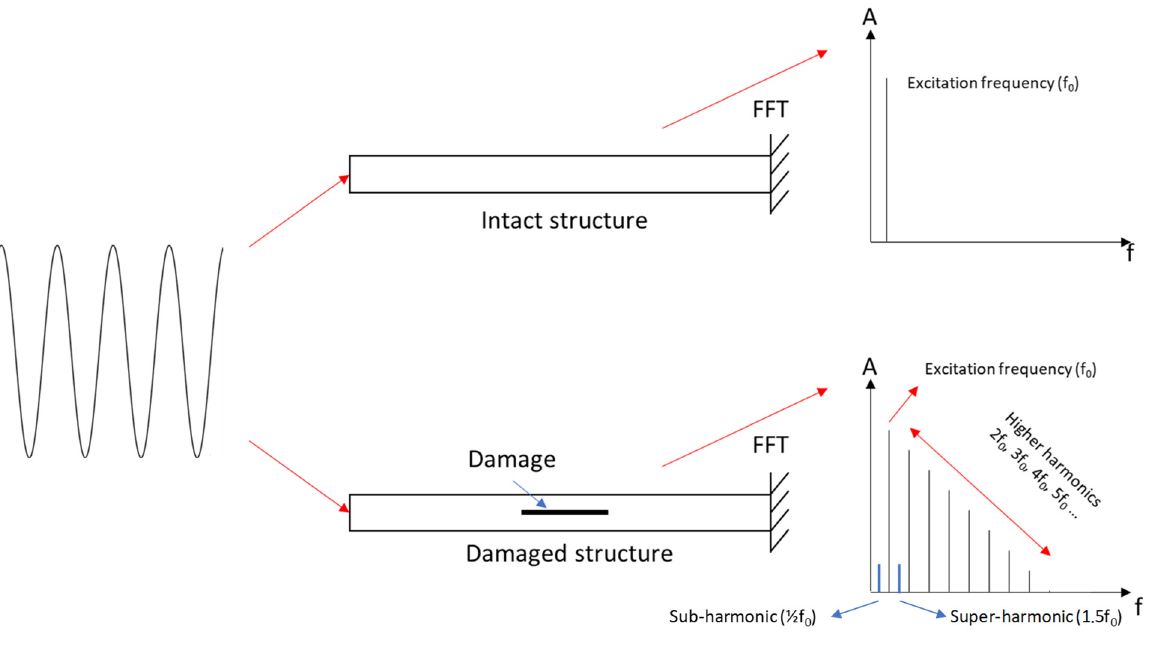
Figure 8. Sub- and super-harmonics generation method (adapted from [37]).